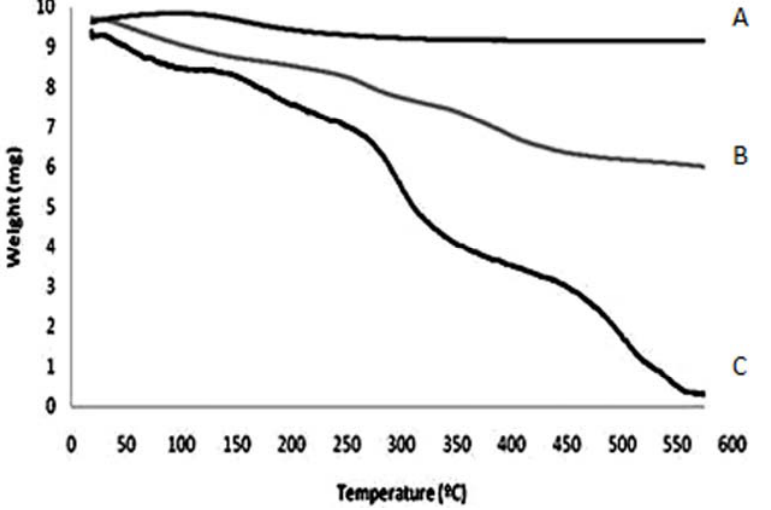
Figure 3. TGA results of pure zeolite powder ( A ), chitosan/zeolite film ( B ) and chitosan film ( C